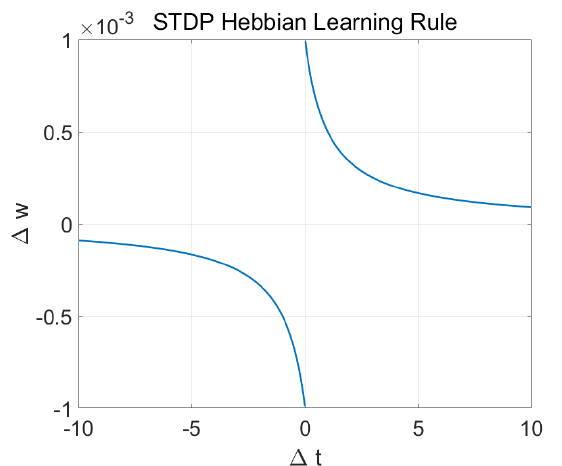
Figure 10. Hebbian Learning rule, connection (synaptic modification) vs difference between post- and pre-synaptic